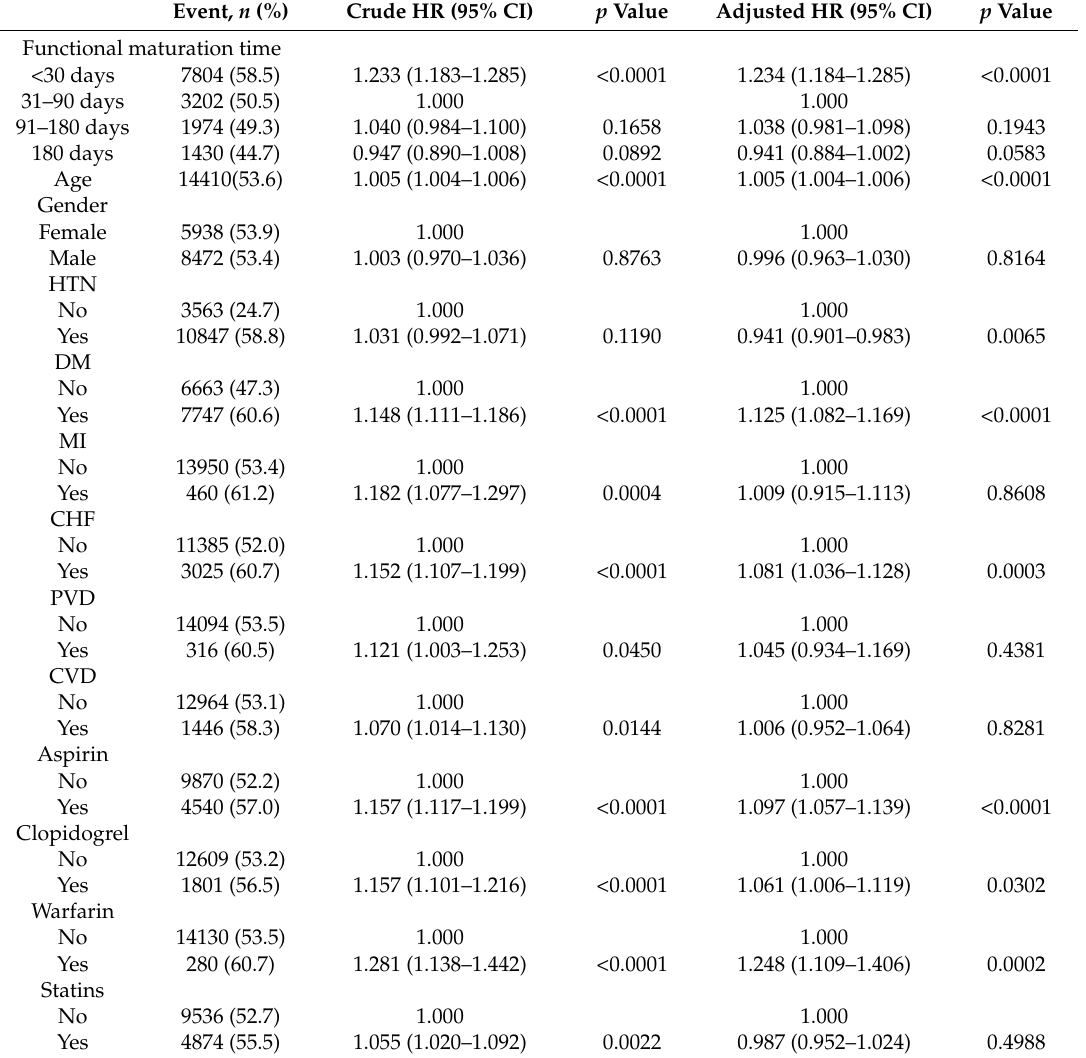
Table 3. Hazard ratios for functional primary patency of